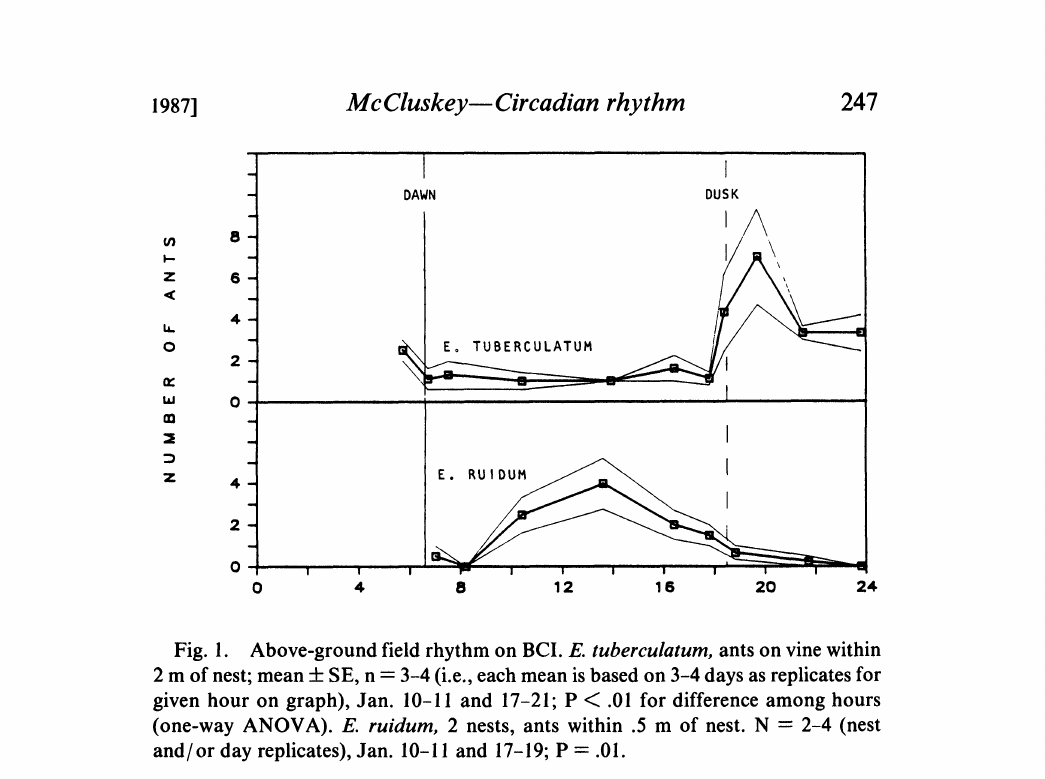
Fig. 1. Above-ground field rhythm on BCI. E. tuberculatum, ants on vine within 2 m of nest; mean -I- SE, n 3-4 (i.e., each mean is based on 3-4 days as replicates for given hour on graph), Jan. 10-11 and 17-21; P < .01 for difference among hours (one-way ANOVA). E. ruidum, 2 nests, ants within .5 m of nest. N 2-4 (nest and/or day replicates), Jan. 10-11 and 17-19; P